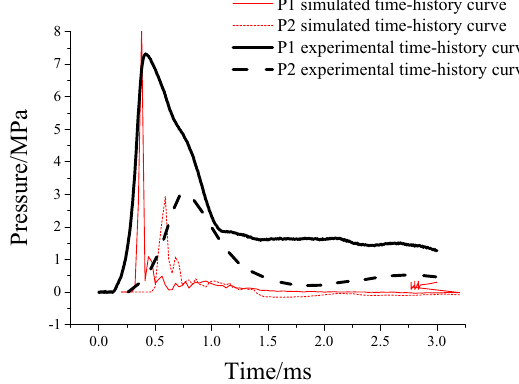
Figure 7. Comparison of simulated and measured compressive stress time-history curves.